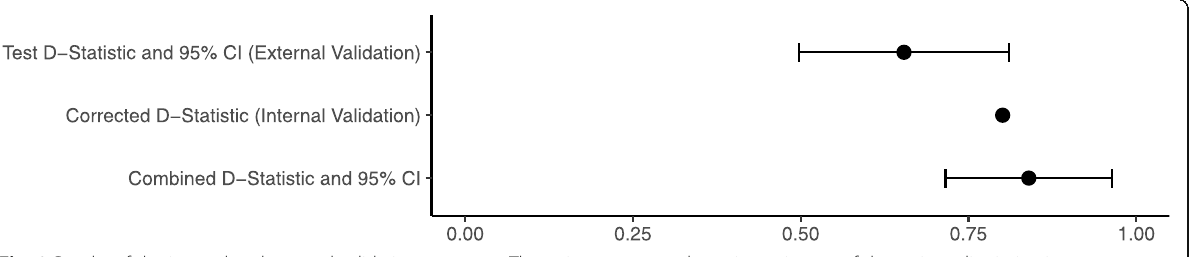
Fig. 2 Results of the internal and external validation processes. The points represent the point estimates of the various discrimination measures and the horizontal lines show the 95% confidence intervals, where